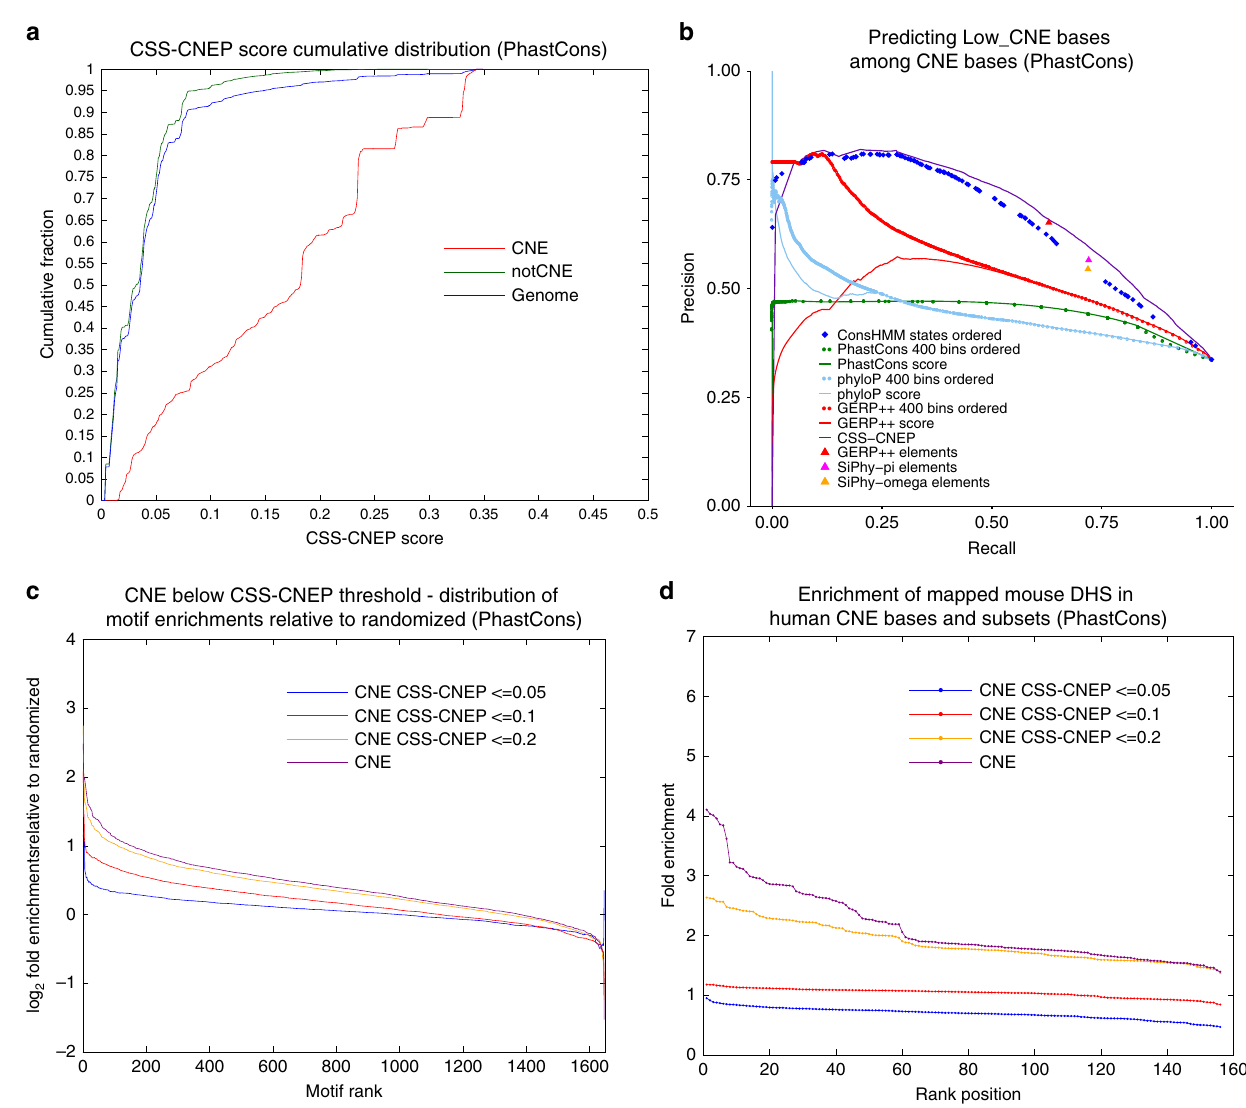
Fig. 7 Conservation signature score by CNEP (CSS-CNEP). a Cumulative distribution of the CSS-CNEP score genome-wide and speci fi cally in CNE